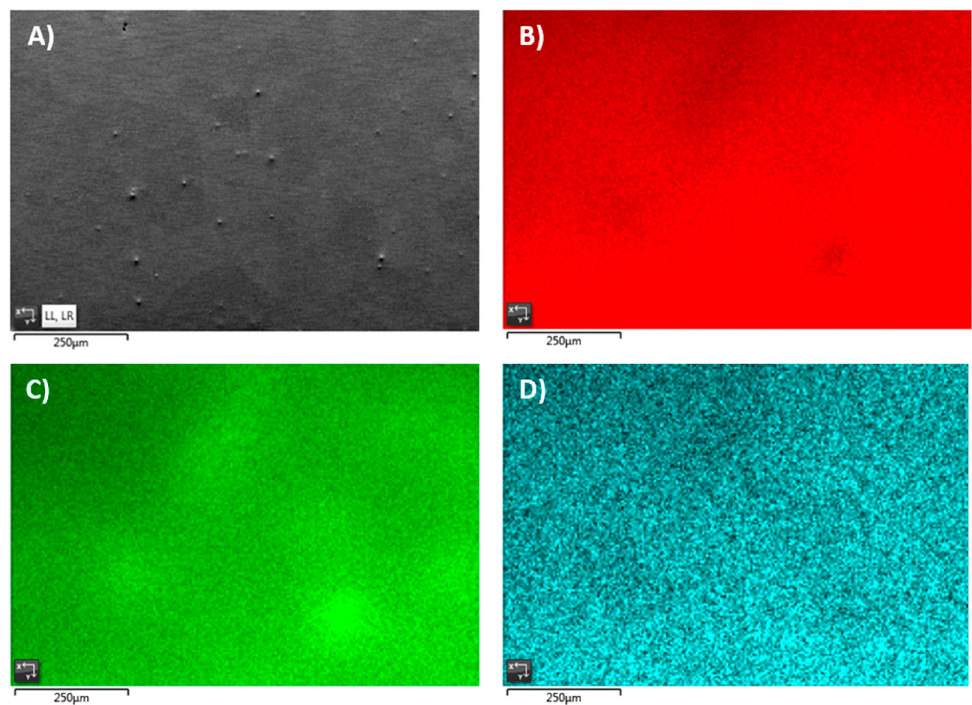
Figure 4. SEM and EDS mapping of Ti, Nb, and Sn respectively, for Ti35Nb2Sn HIPed at 1200 °C, 150 MPa and cooled at 100 °C/min (HIP 2). ( A ) SEM image. ( B ) Titanium EDS mapping. ( C ) Niobium EDS mapping. ( D ) Tin EDS mapping.